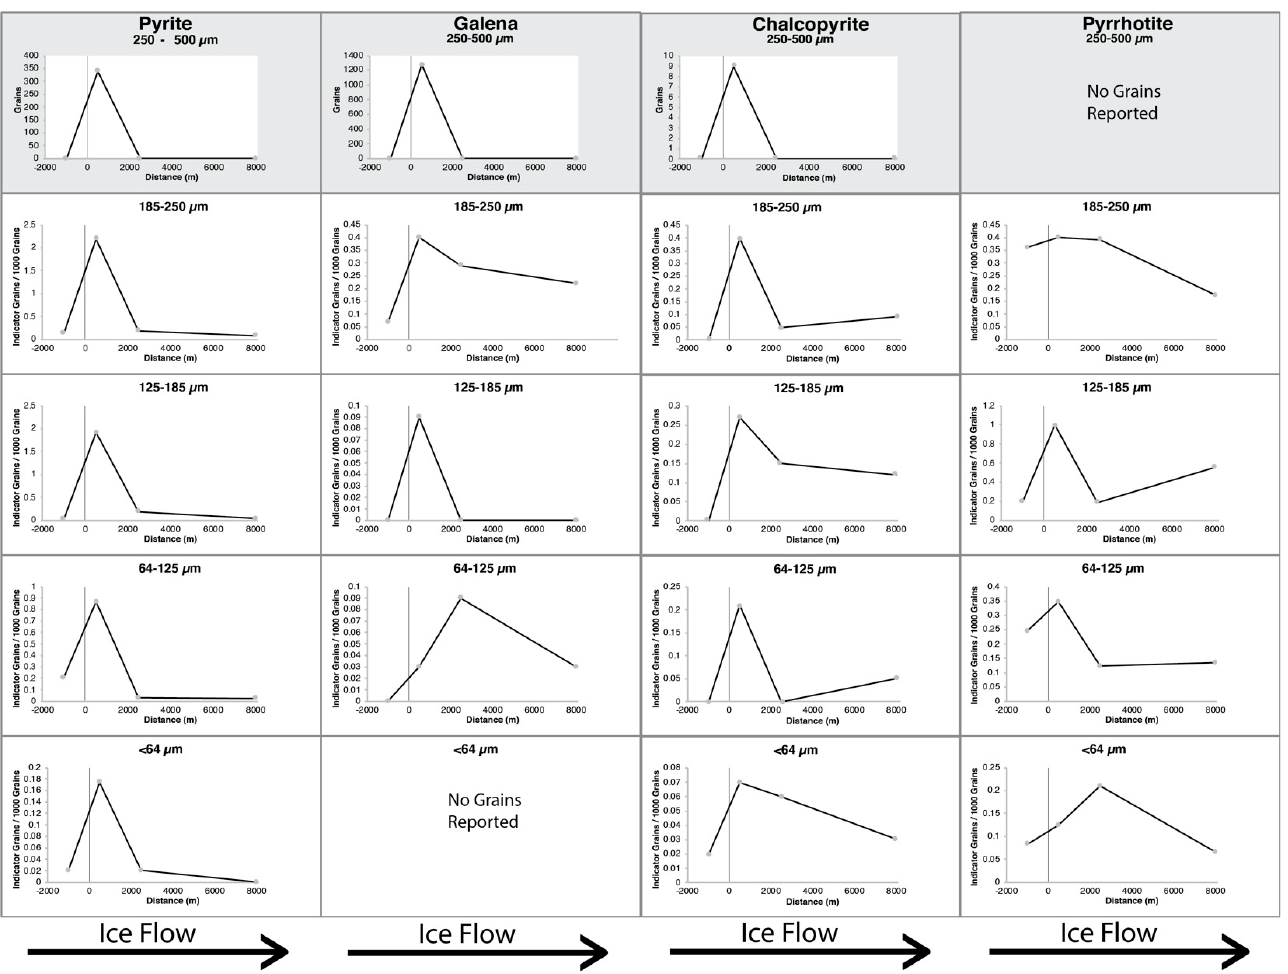
Figure 7. The grain abundance (normalized to 1000 grains) of ore indicator minerals at each sample location, for each size fraction examined. The X-axis of each is a scaled representation in the direction of ice flow (black arrow). The location of mineralization is denoted by the vertical grey line, and the black trend-line depicts the inferred decay in indicator mineral abundance along the dispersal train extending from the deposit.